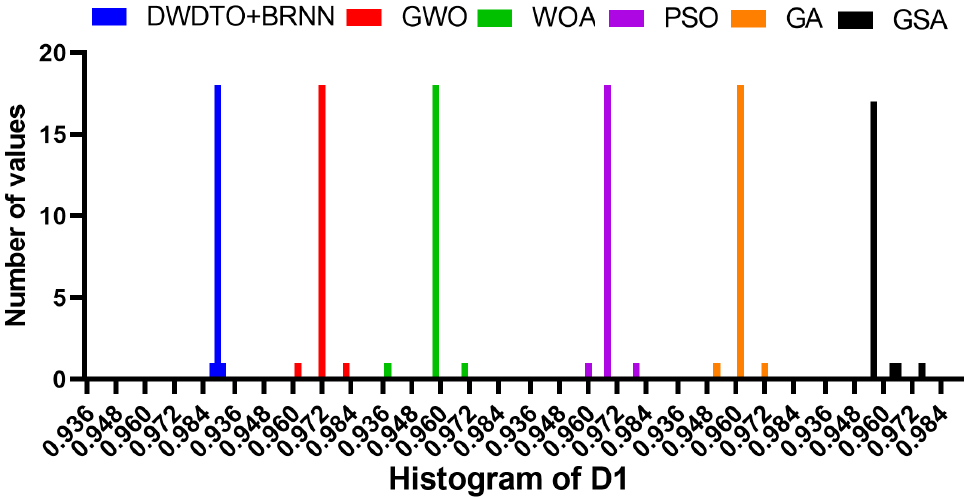
Figure 11. Histogram of the accuracy achieved by the proposed approach and other optimization approaches in terms of the first dataset